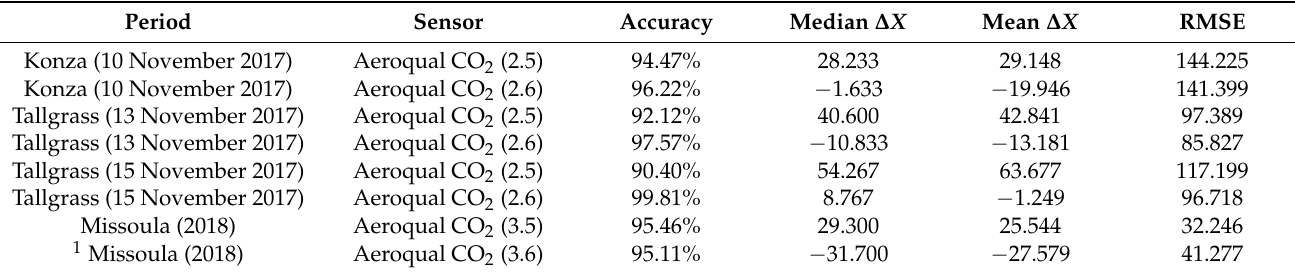
Table A4. Sensor versus reference difference statistics for CO 2 .